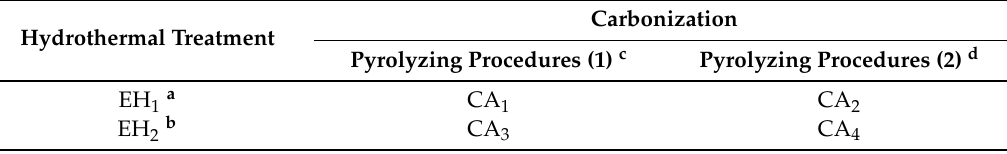
Table 2. Treatment methods and pyrolyzing procedures for preparing carbon